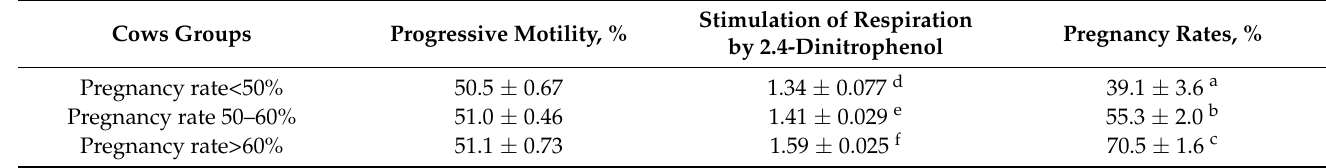
Table 3. Pregnancy rates of bovine semen with different stimulation rates by 2.4-dinitrophenol.